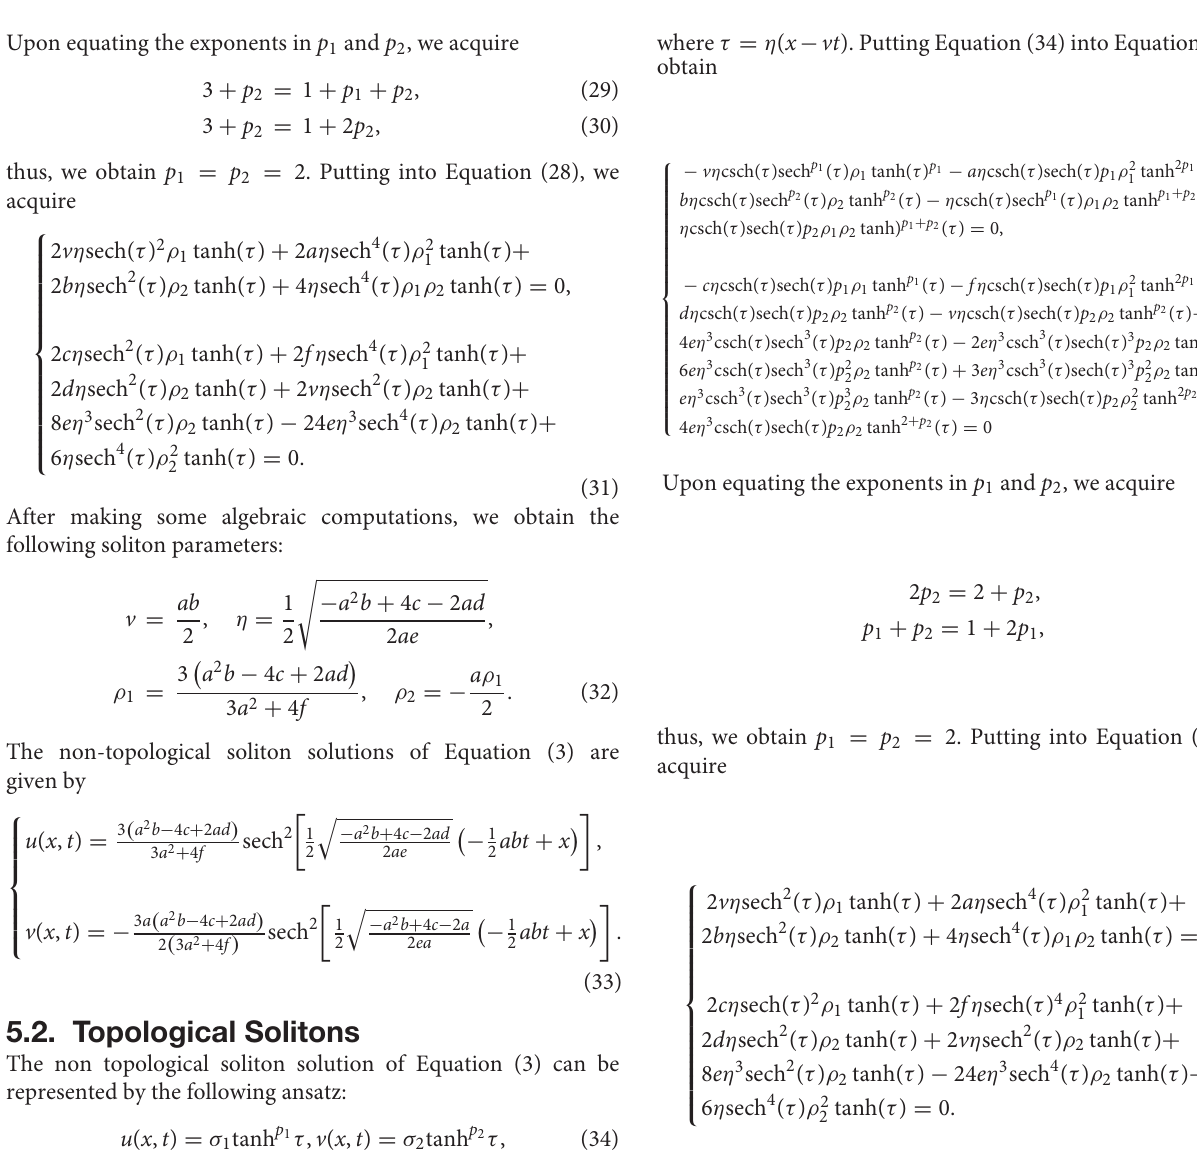
FIGURE 1 | Surface profile of the algebraic functions solutions A and B mathematically represented by Equation (26) by setting c 1 = 0.5, c 2 = − 0.2, c 3 = 0.2, d =